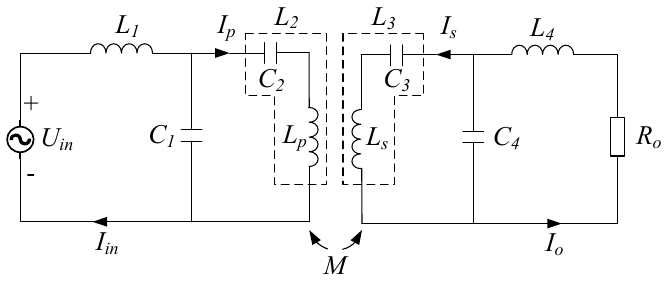
Figure 2. Circuit of DLCC compensation topology .